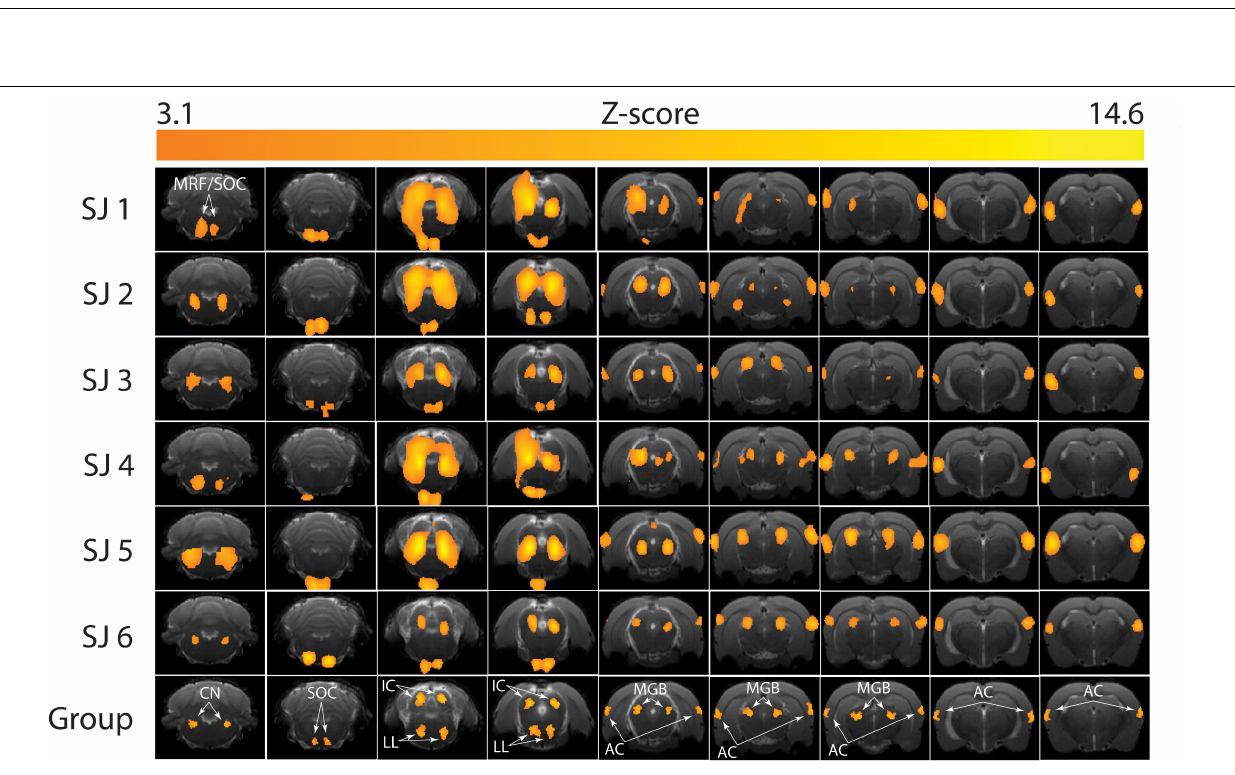
Frontiers in Neuroscience |